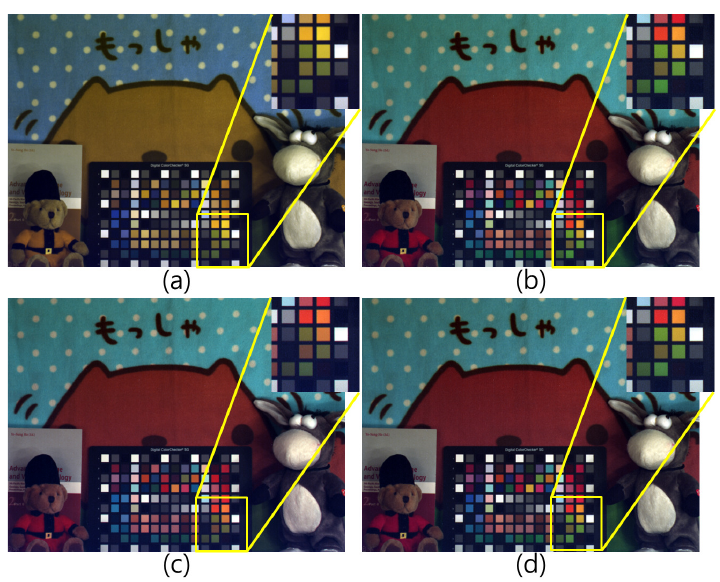
Figure 10. Experimental results (incandescent lamp): ( a ) RWB image before RGB color conversion; ( b ) RGB color image; ( c ) 3 × 3 CCM; and ( d ) Proposed method.